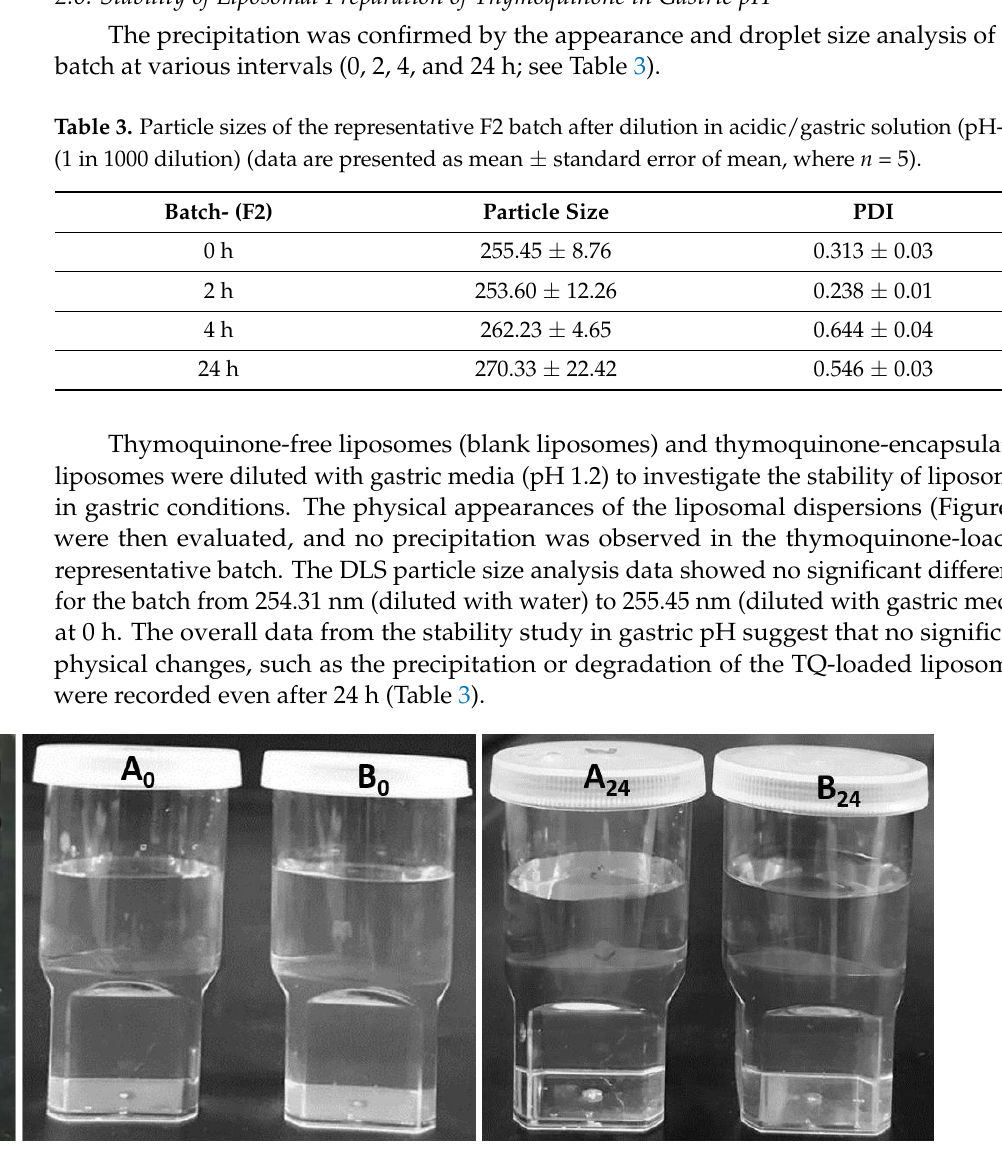
Figure 5. Liposomal formulation (F2) before dilution [F] and after dilution (1 in 1000 dilution, 1 mg/mL): A 0 and A 24 with water at 0 h and 24 h, and B 0 and B 24 with gastric pH (1.2 pH) at 0 h and 24 h, respectively.